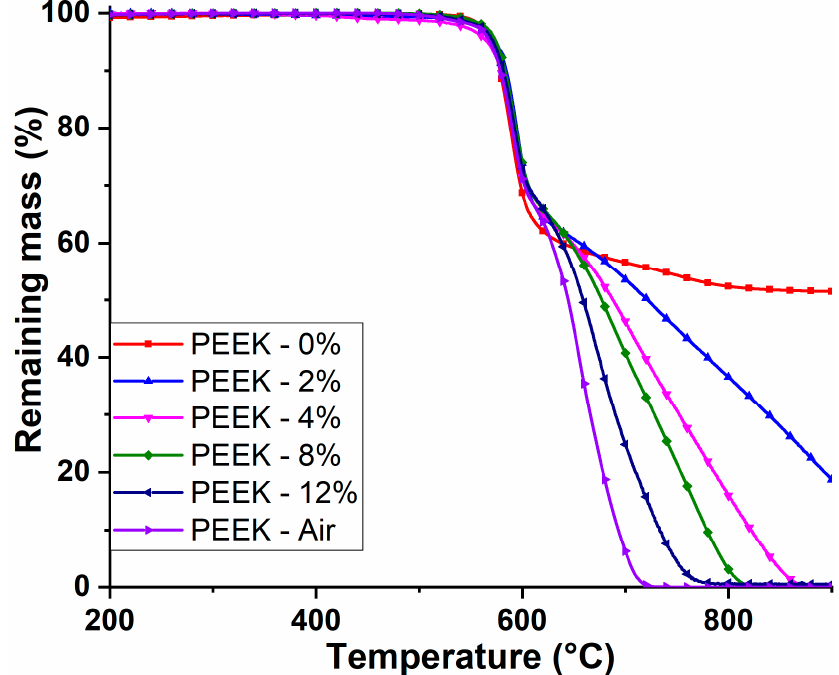
Figure 1. TG plots for polyetheretherketone (PEEK) at a heating rate of 10 °C/min under different oxygen concentrations.